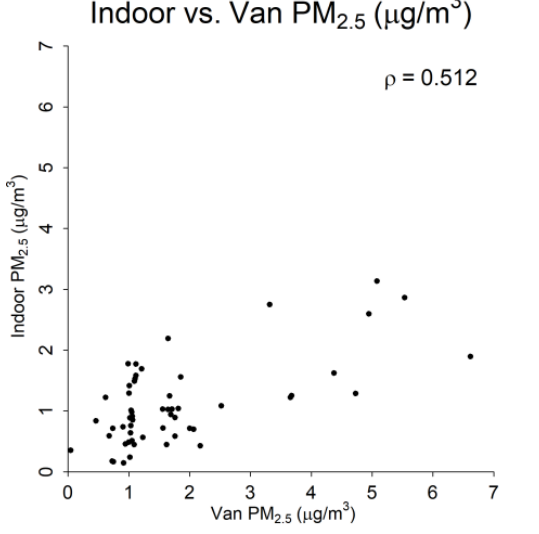
Figure 5. Site pollutant readings comparisons for Willow Springs campaign (10–28 January 2020) for fine particulate matter.